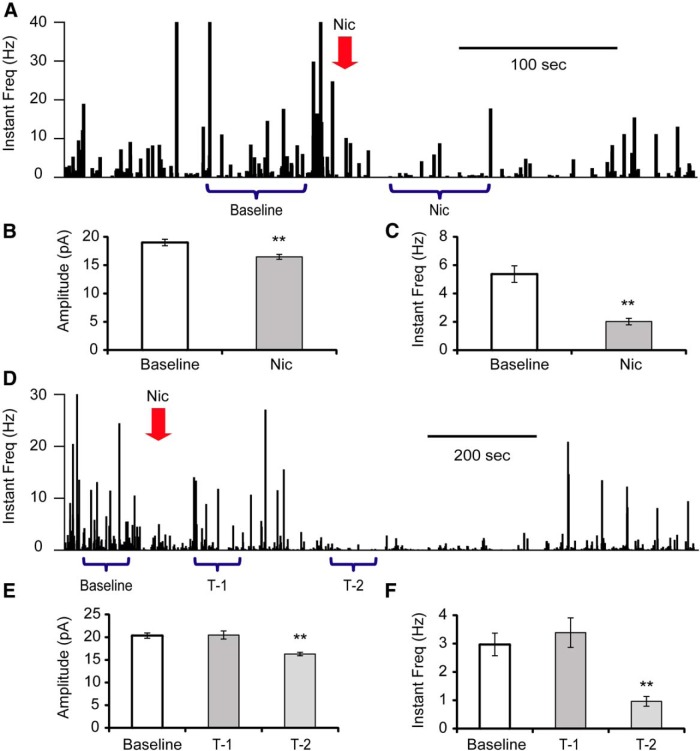
Effects of nicotine exposure on glutamatergic mEPSCs onto Hcrt+ neurons. A, Histograms of mEPSC instantaneous frequency showing the effect of nicotine (Nic) exposure (100 µM) on mEPSCs onto Hcrt+ neurons. The arrow indicates the time of nicotine application. Depending on the response pattern, two periods of time (baseline and Nic) were used for analysis. B, C, Mean value of amplitude (B) and instantaneous frequency (C) at baseline and under the influence of nicotine. n = 4 of 11 cells. **p < 0.01. D, Histograms show another representative response to nicotine (1 µM) on mEPSCs onto an Hcrt+ neuron. Three periods of time (baseline, T-1, and T-2) were used for analysis. E, F, Mean value of amplitude (E) and instantaneous frequency (F) of mEPSCs during baseline recording and at two periods after nicotine exposure. n = 4 of 11 cells.